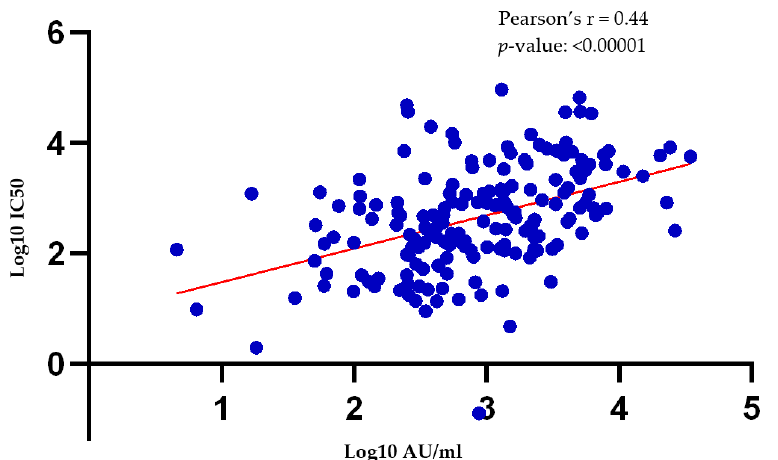
Figure 4. Correlation of log10 IC50 and log10 AU/ml values obtained following pseudotyped lentivirus antibody neutralization assay, and SARS-CoV-2 IgG II Quant immunoassay, on samples from each of the three groups of study participants.